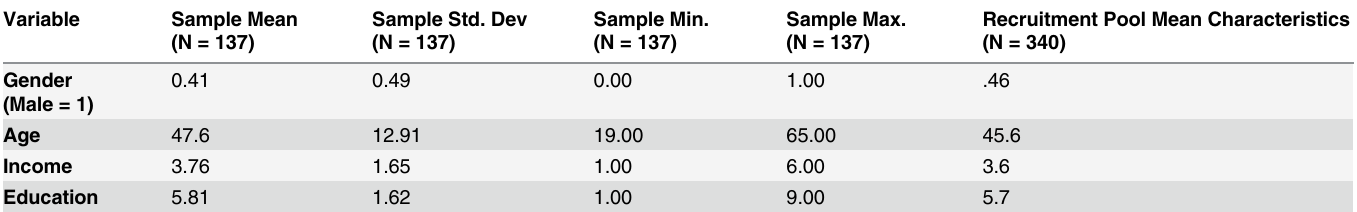
Table 1. Characteristics of Study Sample and Recruitment